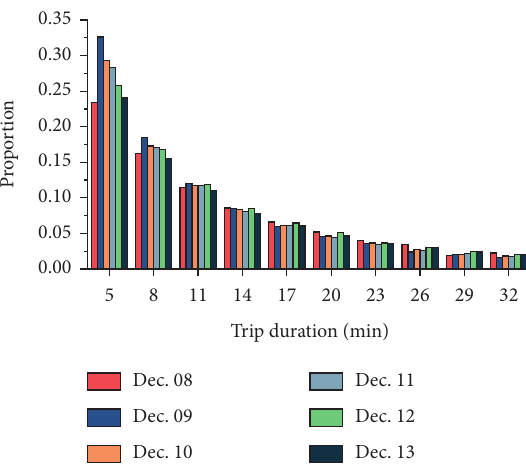
Figure 9: Interval distribution of trip durations during the 6 days.